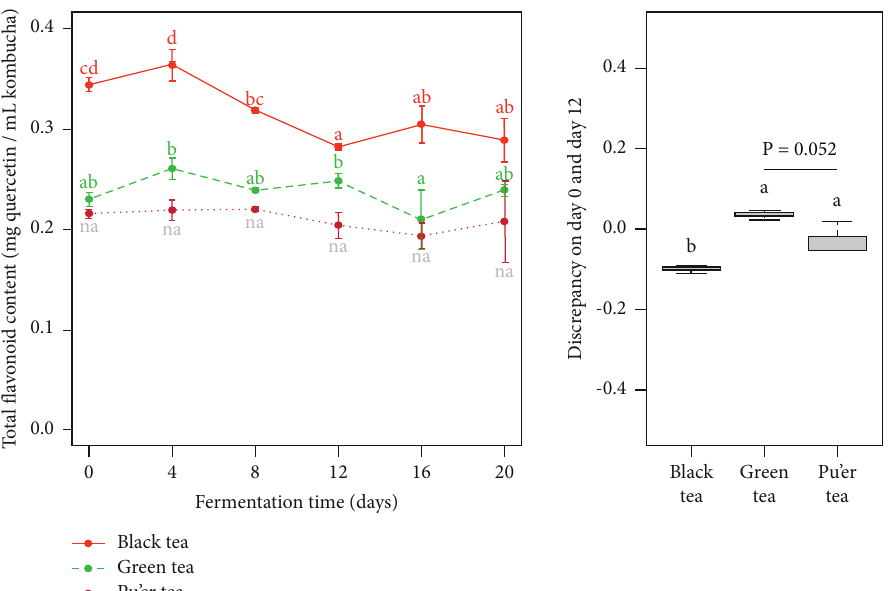
Figure 3: Total flavonoid content (a) and discrepancy value (b) during fermentation of kombucha prepared from green, black, and pu’er teas. Different letters indicate significant differences between the tea groups ( p < 0 .